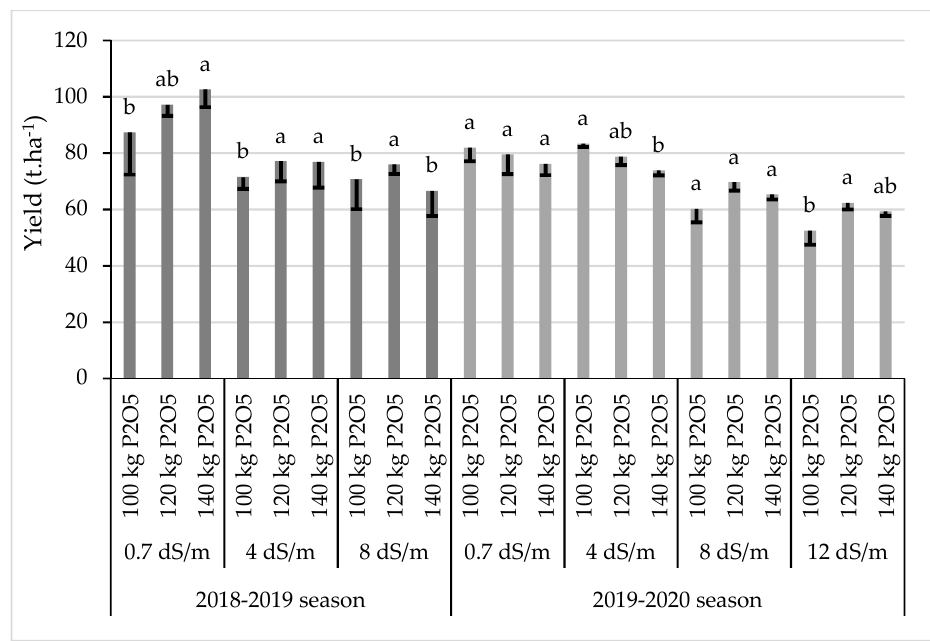
Figure 3. Sugar beet yield as affected by salinity and P application for both seasons (2018–2019 and 2019–2020). Error bars indicate the standard deviation. Phosphorus treatments under the same salinity level without a common letter are significantly different at p < 0.05.